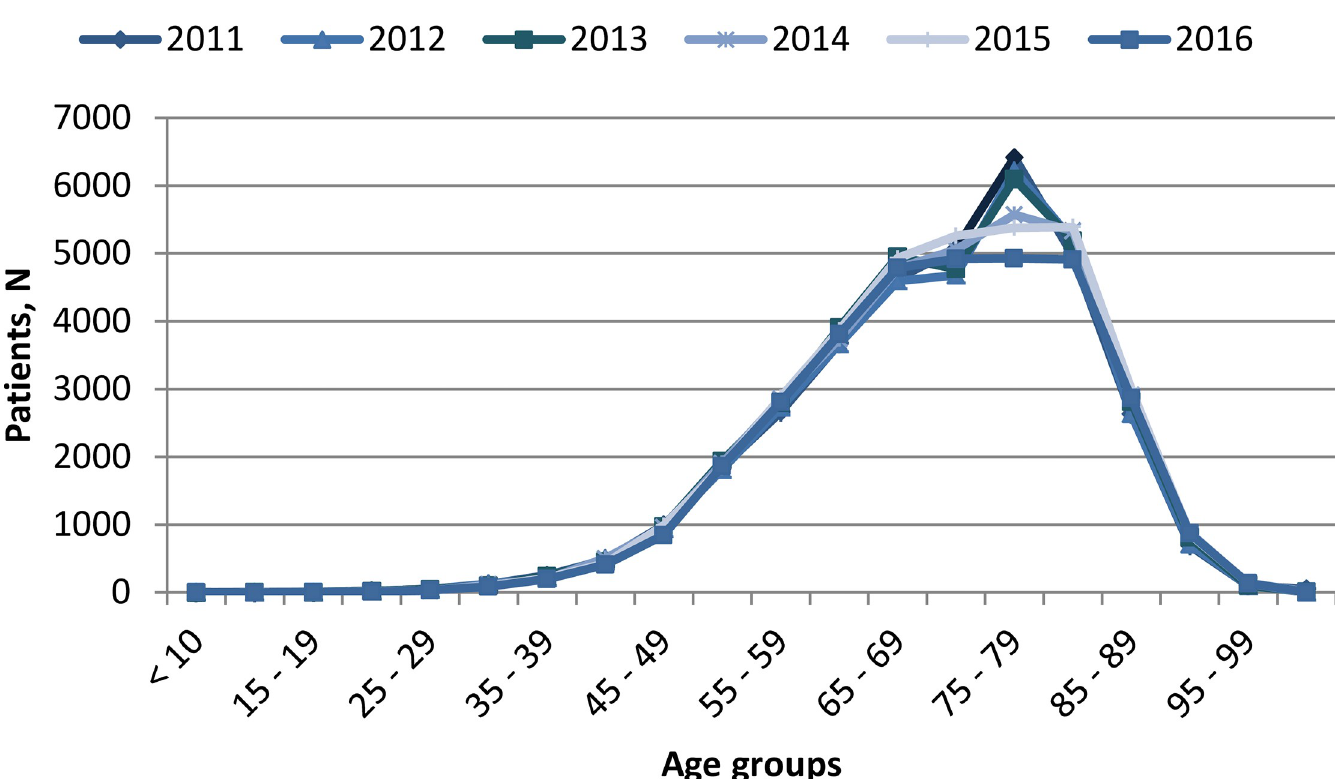
Fig 1. Patients’ age at first hospital admission per colorectal cancer the years 2011–2016.